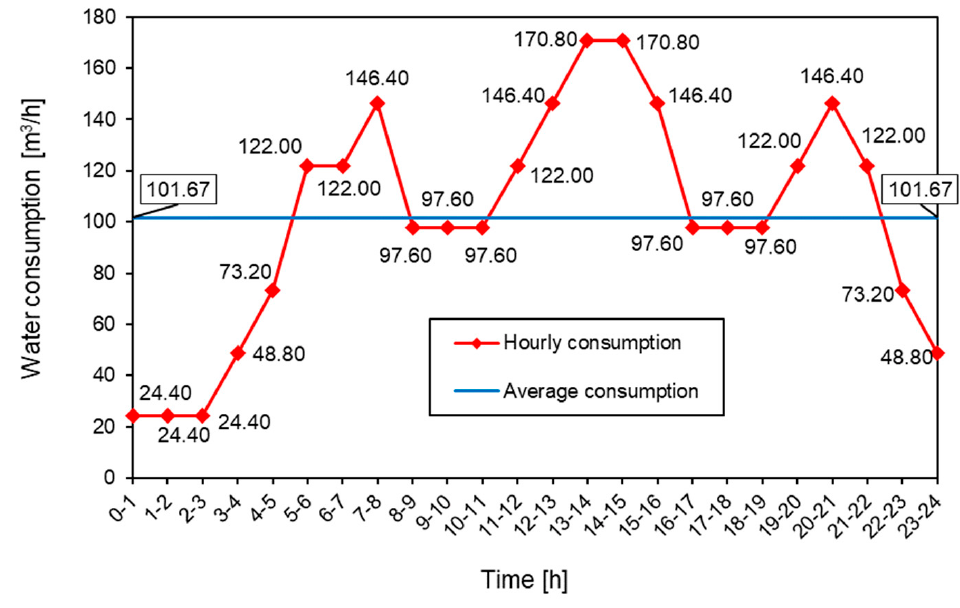
Figure 4. Daily water consumption regime for 𝑄 𝑑𝑎𝑖𝑙𝑦 =2440 m 3 /day—Variant I [12].